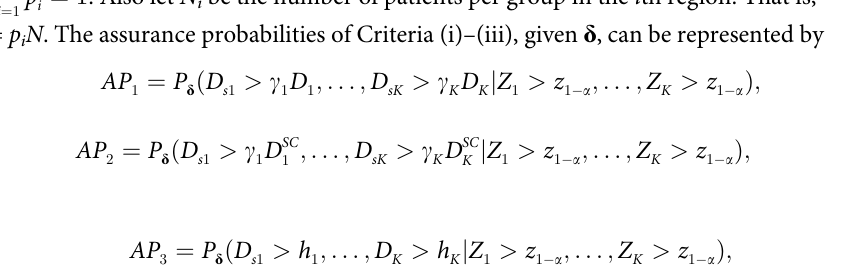
ffiffiffiffiffiffiffiffiffiffiffiffi 2 = Np